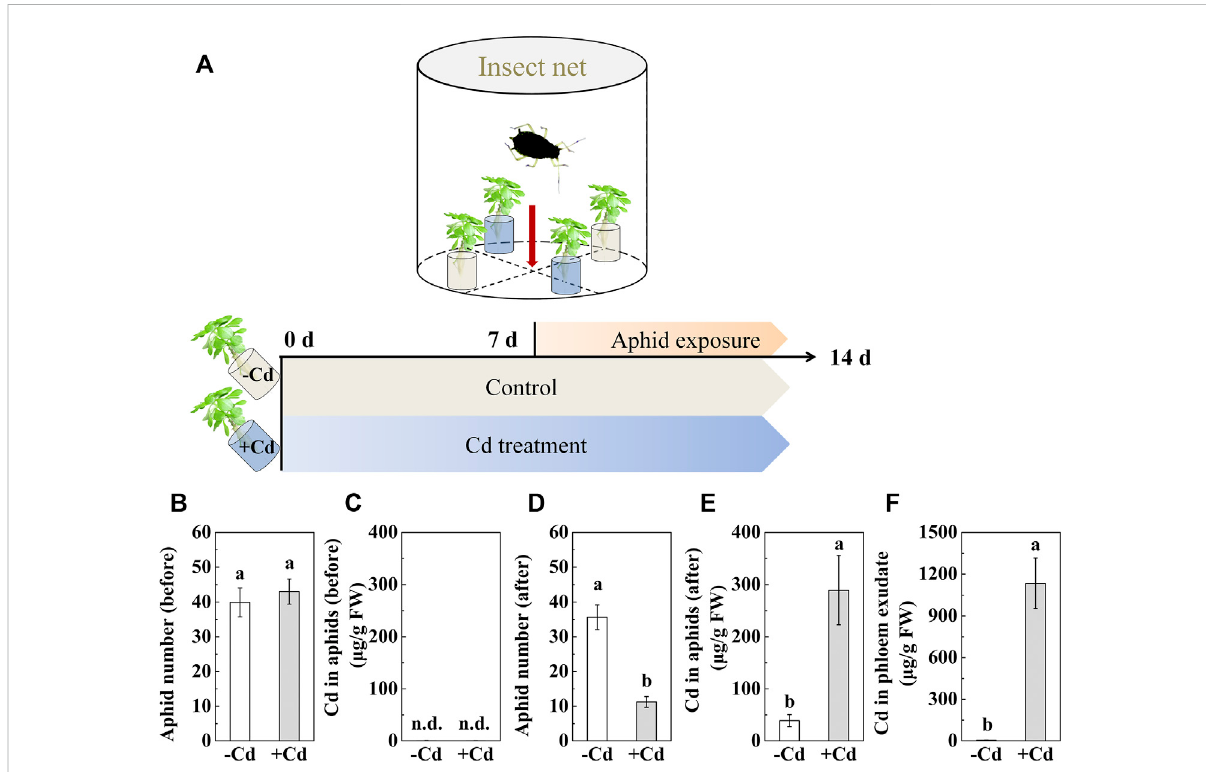
FIGURE 1 Short-term effect of Cd accumulation on aphid ( Aphis fabae Scopoli) colonization in the Cd hyperaccumulator Sedum alfredii in a small and closed environment. (A) Experimental procedure. Four-week-old seedlings were pretreated with 0 (-Cd) or 100 μ mol · dm ⁻ ³ (+Cd) CdCl 2 for 7 days andwerethenexposedtoaphidsthatwerecollectedfromCd-free S.alfredii plants(mainlyusedforaphidculture)foranother7 daysoftreatment.In this period, the plants infested with aphids were continuously treated with 0 or 100 μ mol · dm ⁻ ³ CdCl 2 . (B) Number of adult aphids on S. alfredii with 0or 100 μ mol · dm ⁻ ³ Cdafter 1 hof infestation with 200 aphids randomly placed ineach box. (C) Cd concentration inaphids before culturing on Cd-pretreated plants. (D) Number of adult aphids on S. alfredii with 0 or 100 μ mol · dm ⁻ ³ Cd after 7 days of infestation with 200 aphids randomly placed in each box. (E) Cd concentration in surviving aphids after 7 days of culturing in S. alfredii . (F) Cd concentration in phloem exudates collected from leaves of S. alfredii after being treated with 0 or 100 μ mol · dm ⁻ ³ CdCl 2 for 14 days. Data are shown as means ± SD (n = 4). Different letters indicate signi fi cant differences between the control and Cd-treated plants ( t -test, p < 0.01). n. d. indicates that the Cd content was too low to be detected. FW, fresh